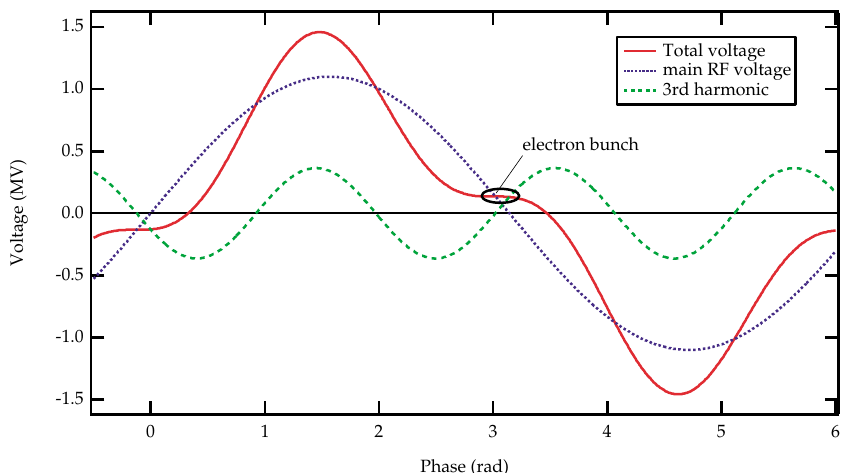
FIG. 1. (Color) rf voltage seen by the bunch for main rf and higher harmonic